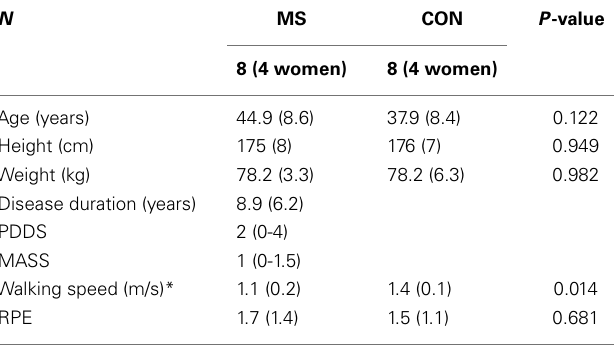
Table 1 | Subject characteristics and clinical measures